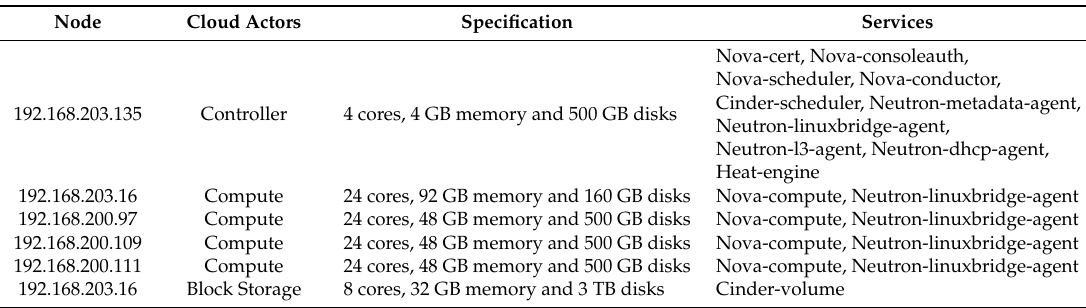
Table 1. Specification of the OpenStack cloud computing environment.